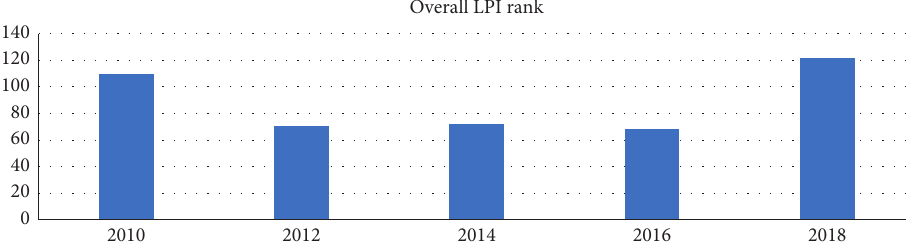
Figure 1: Logistic performance index (LPI) rank of Pakistan from 2010 to 2018. The x -axis shows the years, and the y -axis shows the LPI rank (source: https://lpi.worldbank.org/international/scorecard/radar/8/C/PAK/2018).